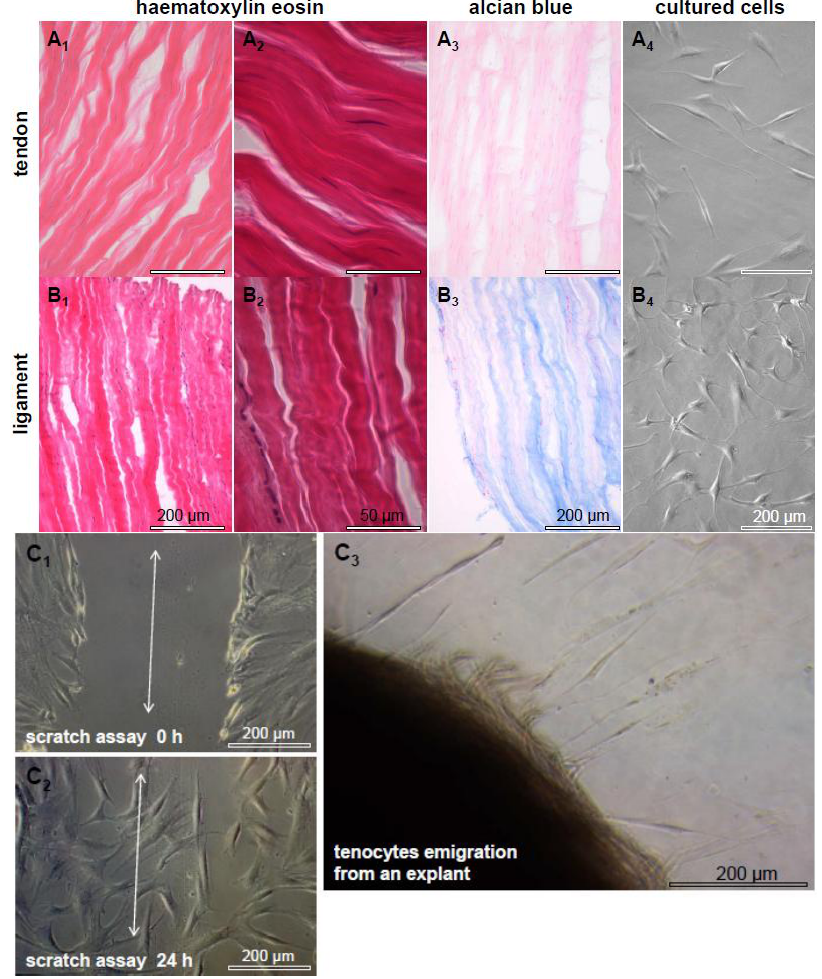
Figure 2. Tendon and ligament. Haematoxylin eosin ( A , B ) stainings of a human hamstring tendon and an anterior cruciate ligament are ( A 3 3 shown. The cell nuclei of the ligament are more rounded, the ligament ECM has a more crimp appearance and contains more sulphated proteoglycans compared with the tendon. Longitudinal (cid:86)(cid:72)(cid:70)(cid:87)(cid:76)(cid:82)(cid:81)(cid:86)(cid:3)(cid:68)(cid:85)(cid:72)(cid:3)(cid:86)(cid:75)(cid:82)(cid:90)(cid:81)(cid:17)(cid:3)(cid:54)(cid:70)(cid:68)(cid:79)(cid:72)(cid:3)(cid:69)(cid:68)(cid:85)(cid:86)(cid:29)(cid:3)(cid:21)(cid:19)(cid:19)(cid:3)(cid:541)(cid:80)(cid:3)(cid:11) A B ). Isolated and cultured cells of the tendon ( A 2 depictured. Cells of both tissues form multiple cell (cid:177) cell contacts in culture. Migrating human tenocytes in response to a scratch in the cell layer ( C ). Tenocytes, which migrate from a tendon explant 1 week after fill the gap within 24 h ( C 2 starting the culture, are shown ( C 3